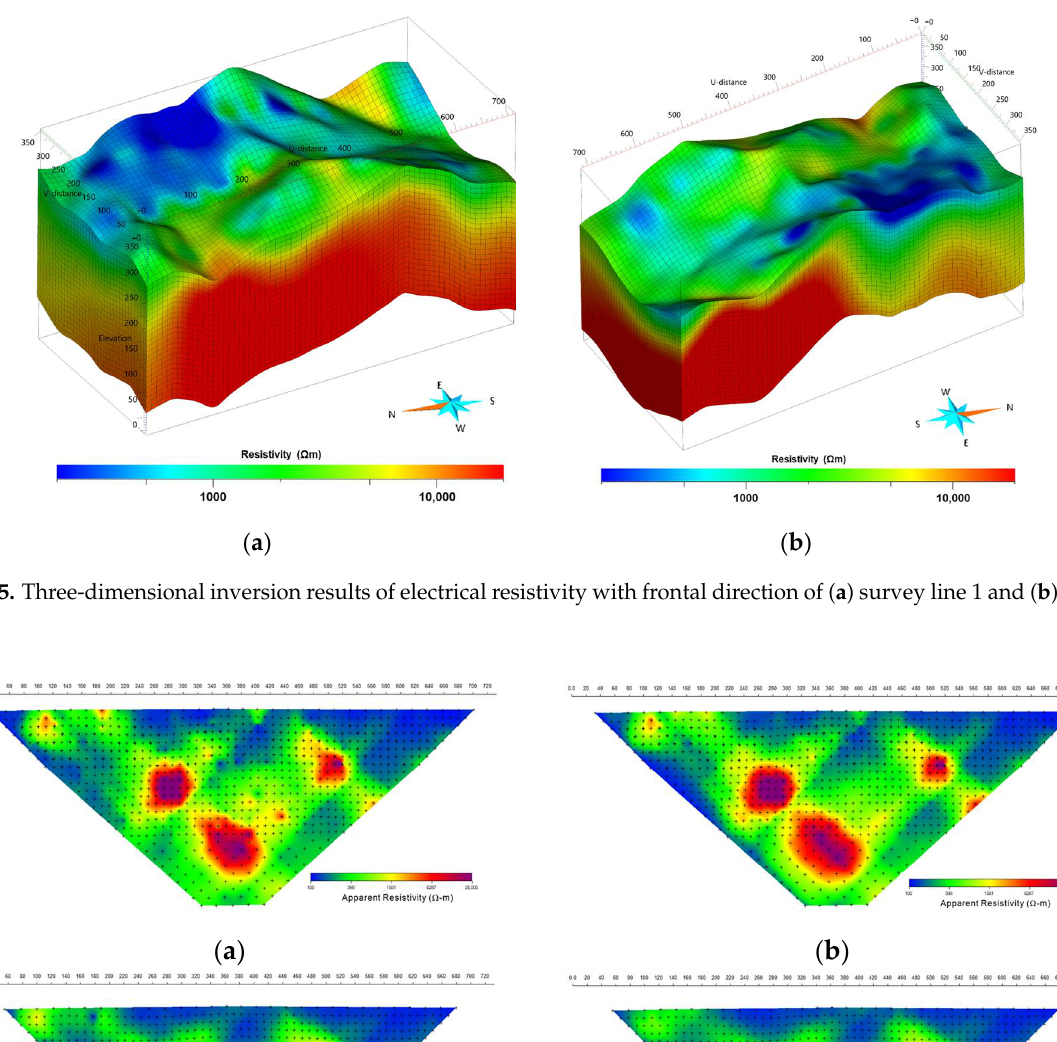
7 of 12 Figure 4. Two-dimensional inversion results of electrical resistivity for ( a ) survey line 1, ( b ) survey line 2, and ( c ) survey line 3. The axis showing distance starts from the north. For a comprehensive interpretation of the subsurface structure, we performed a 3D electrical resistivity inversion. We used only the data with a dipole spacing of 40 and 60 m considering the distance between survey lines. The coordinate transform of topography was applied, which was extracted from the digital map. The electrode locations for the 3D process were properly transformed from the 2D resistivity data. The 3D geomodeling software GOCAD (Emerson, Houston, TX, USA) was used for